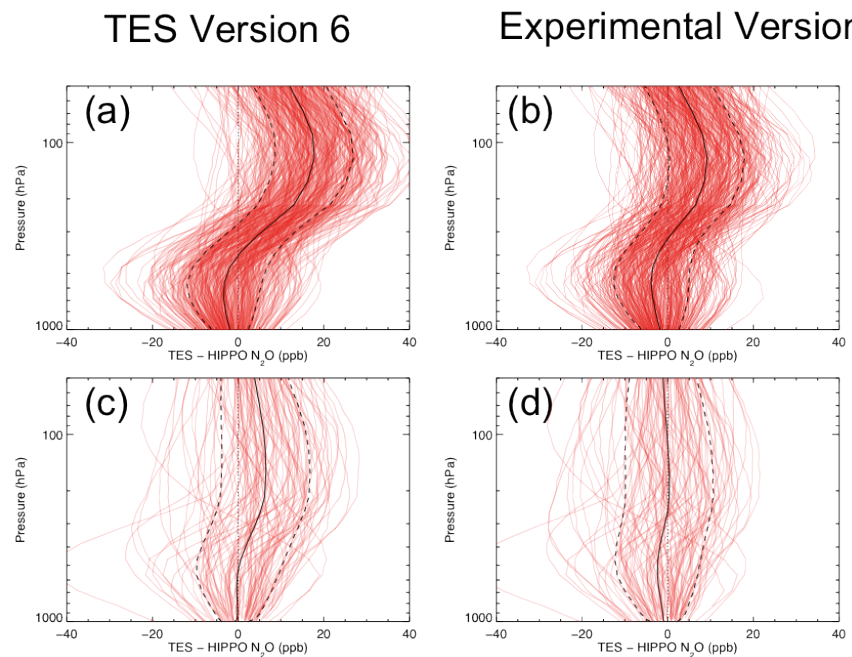
Figure 12. Differences between the retrieved TES N 2 O profiles and the measured HIPPO N 2 O profiles. The red lines are for each TES spectra analyzed, while the black solid line shows the mean differences and the black dashed lines show the standard deviation. (a) TES Version 5 N 2 O for TES CH 4 retrievals with DOFS ≥ 1.6. (b) TES Version 6 N 2 O retrievals with DOFS ≥ 1.6. (c) TES Version 5 N 2 O for TES CH 4 retrievals with DOFS < 1.6. (d) TES Version 6 N 2 O for TES CH 4 retrievals with DOFS <